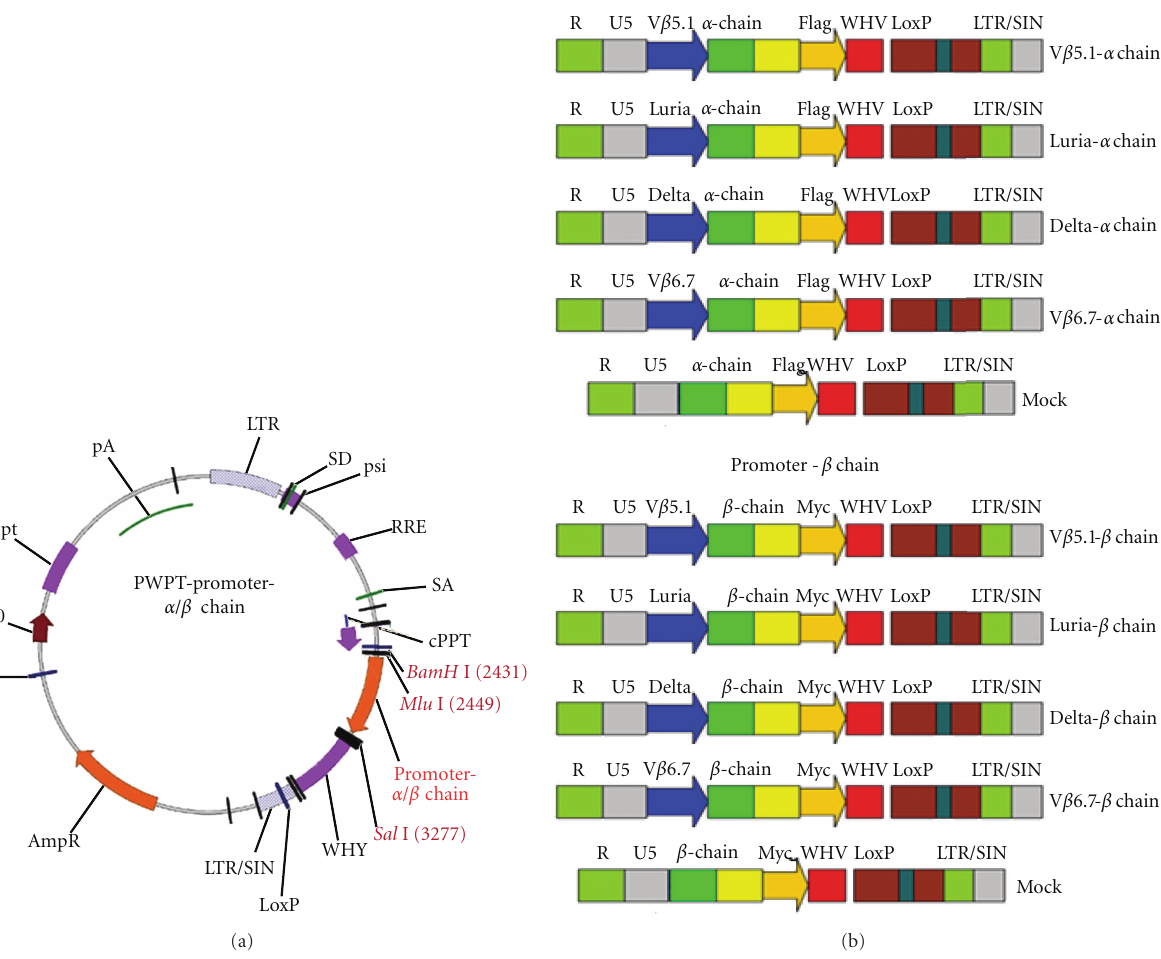
Figure 1: The map of lentiviral vector pWPT-promotor- α / β chain and the schematic diagrams representing the structures of the lentiviral vectors. (a) The map of lentiviral vector pWPT-promotor- α / β chain. The promoter- α / β chain was amplified by PCR and inserted between Mlu I and Sal I sites. (b) The schematic diagrams representing the structures of the lentiviral vectors. All the α / β chains of the anti-LMP2 TCR PL5.05 were driven by individual T-cell-specific promoter except mock which contains only α or β chains without any promoter region. Promoter- α chains in diagram forms were the lentiviral vectors designed to express α chain driven by V β 5.1, Luria, Delta, and V β 6.7 promoters, respectively. Promoter- β chain used V β 5.1, Luria, Delta, and V β 6.7 promoters to produce the individual β